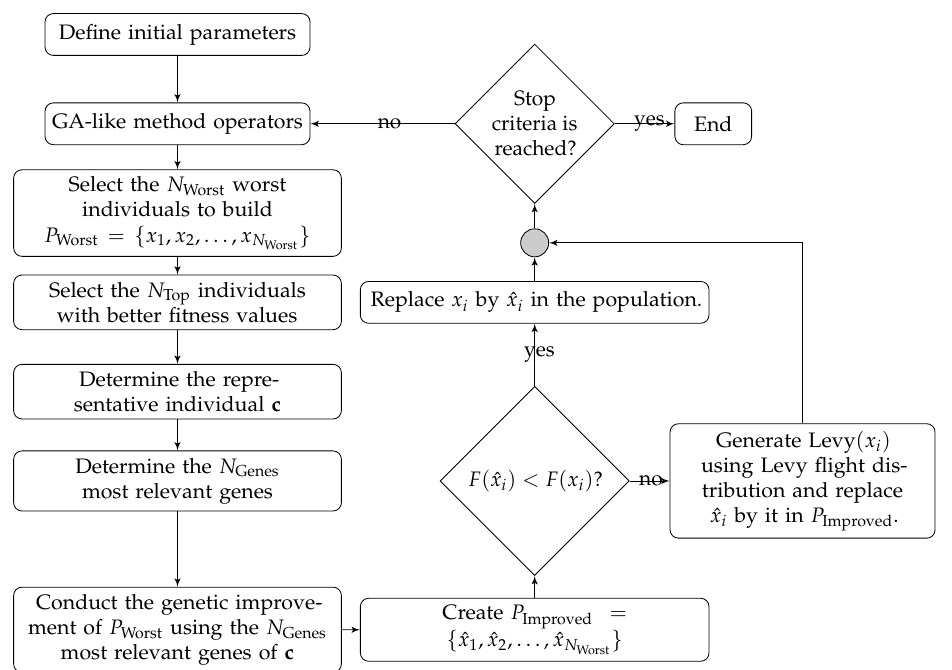
Figure 5. Flow chart of our proposed Genetic Improvement operator for Genetic